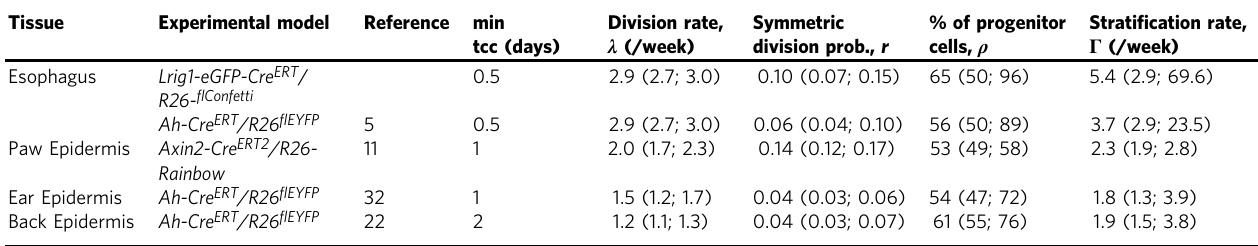
Table 1 Parameter values inferred for progenitor cell behavior in different murine epithelial regions as derived from quantitative lineage tracing.